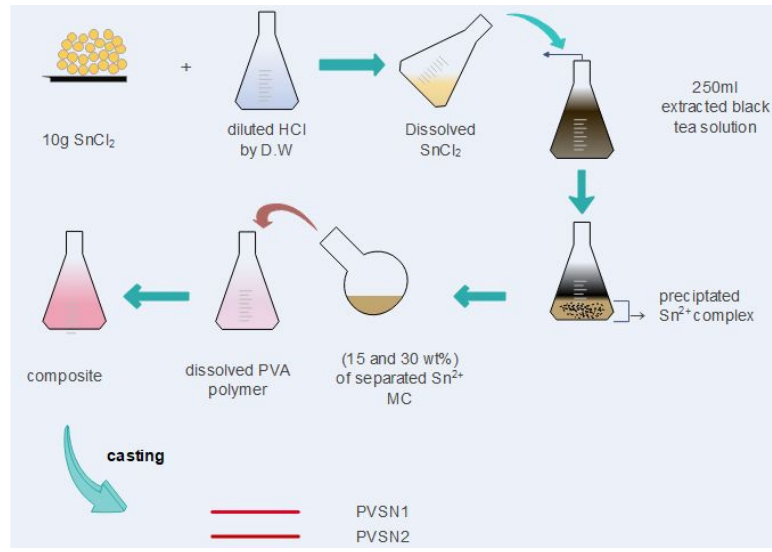
Scheme 1 . schematic diagram of sample preparation . Scheme 1. Schematic diagram of sample